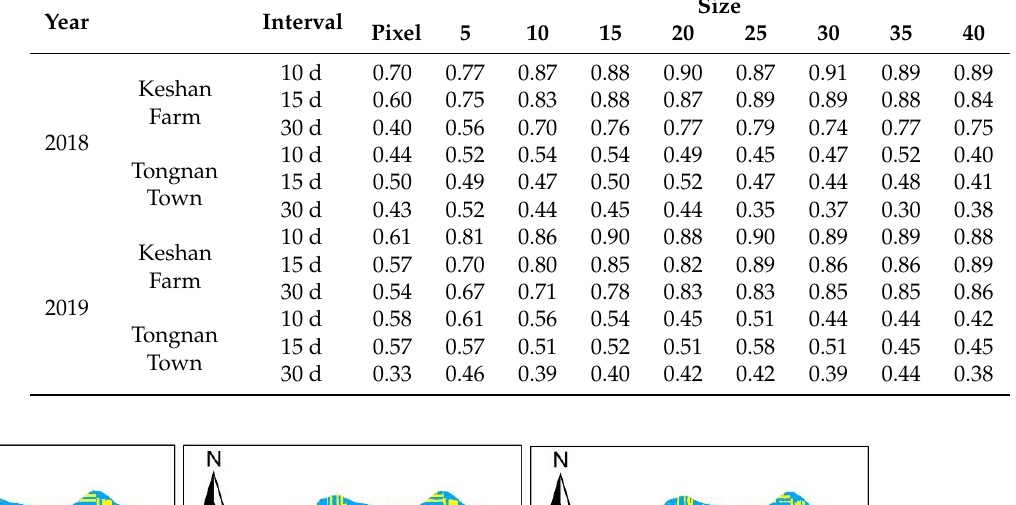
Table 4. The kappa coefficients obtained using different classification schemes in different study areas.